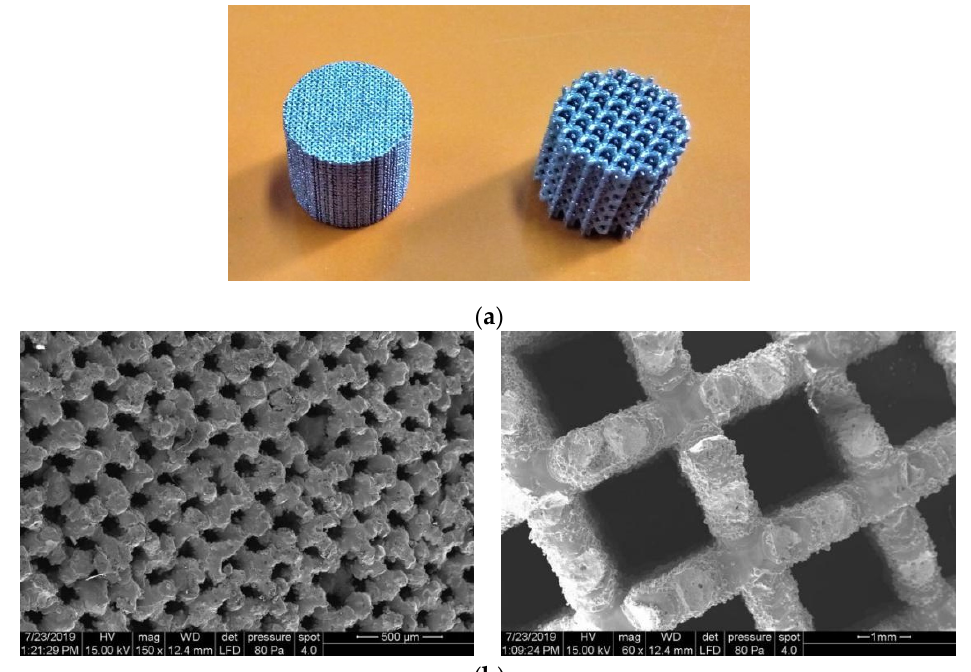
Figure 12. ( a ) Macro-porous scaffolds SLM-manufactured using 316L powder; ( b ) SEM images of BCC structure ( left image ) and CI structure ( right image ).